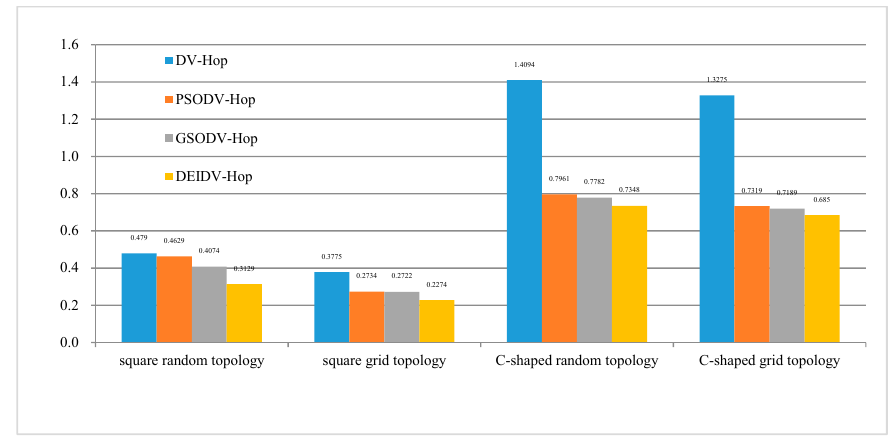
Figure 7. The average value of ALE for four topologies and algorithm.